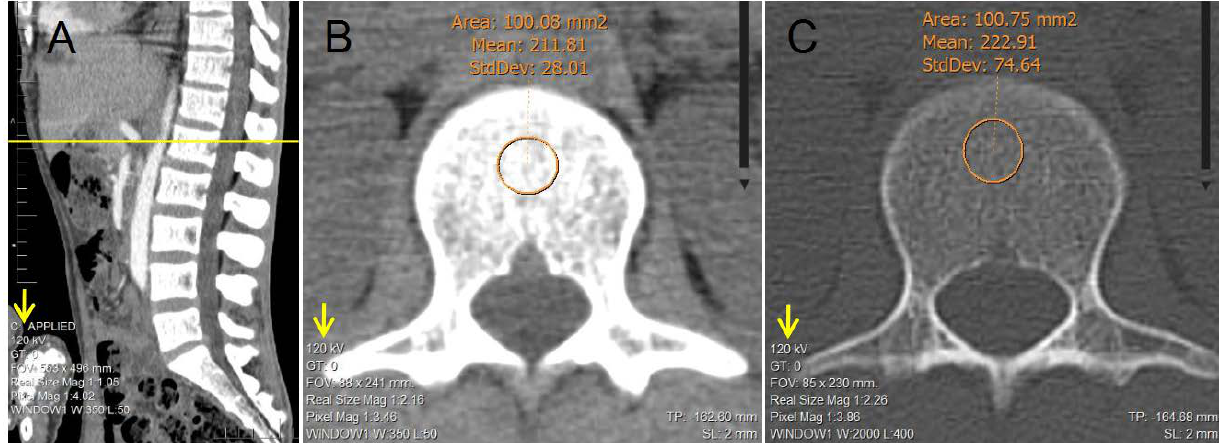
Figure 1. Example of the manual determination of bone mineral density in a 30-year-old male patient of the study; via trabecular attenuation of L1 in Hounsfield units using the oval ROI tool (considering 100 mm 2 ≤ vertebral body trabecular bone area < 101 mm 2 ). ( A ) Sagittal reconstruction of lumbar spine used as a reference to adequately identify L1. ( B ) Axial reconstruction of trabecular L1 vertebral body used for the determination of attenuation via ROI tool in soft tissue window. ( C ) Axial reconstruction of trabecular L1 vertebral body used for the determination of attenuation via ROI tool in bone window.